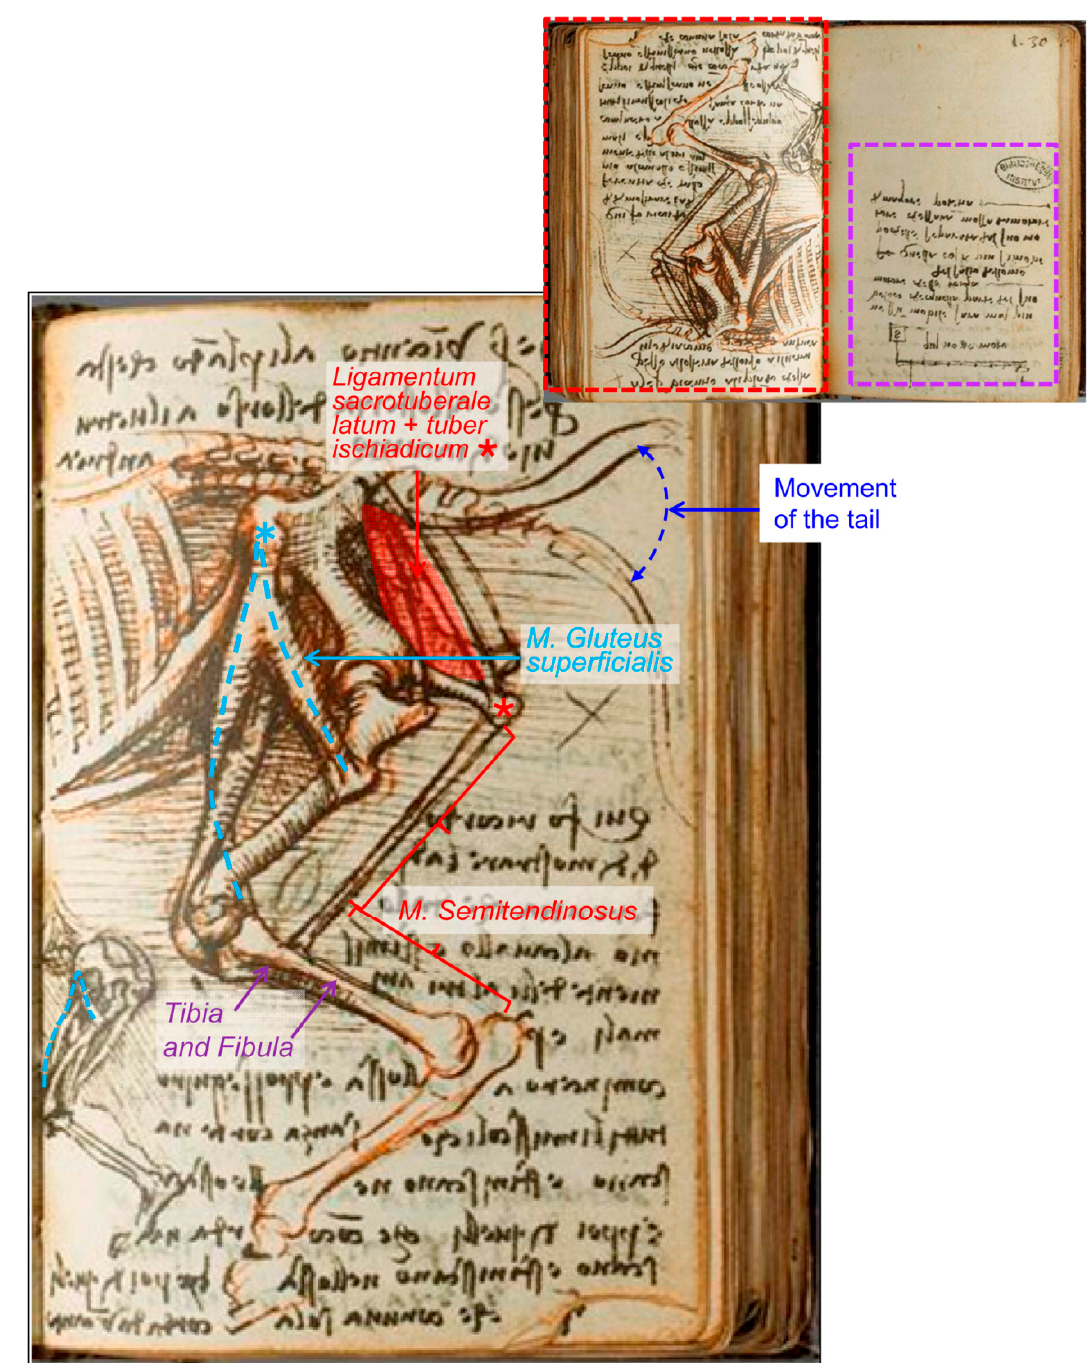
Figure 9. Series of the comparative anatomy of a man’s leg and horse’s pelvic limb—Number 3. ( A ) Two pages: Folio 109 verso (red) and folio 110 recto (violet inset with da Vinci notes about ‘Leviers, movements, saut de l’homme’). ( B ) Folio 109 verso: ‘Anatomie comparée de l’homme et des animaux (chevaux)’. Red inset upside down at higher magnification displaying the comparative between the man left leg (bottom, left) and the horse left pelvic limb, lateral aspect. Modified from Ms 2181-folio 109(29-30) and 110 (30)-manuscrit K (Bibliothèque de l’Institut de France [24]) (1503–1508). This image presentation is authorized in limited time period by R é union des Mus é es Nationaux-Grand Palais (R.M.N.-Grand Palais), and the Bibliothèque de L'Institut de France.